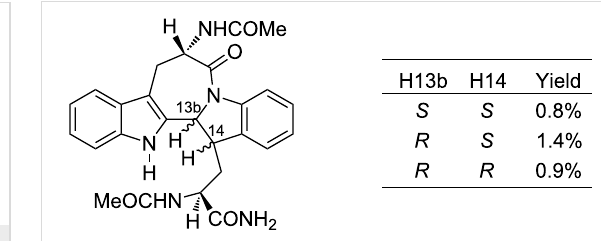
Figure 1: The structure and X-ray crystal structure (ball and stick representation) of azepinodiindolone 7 . The corresponding ORTEP data for 7 , 8 and 9 is reported in Supporting Information File 1.